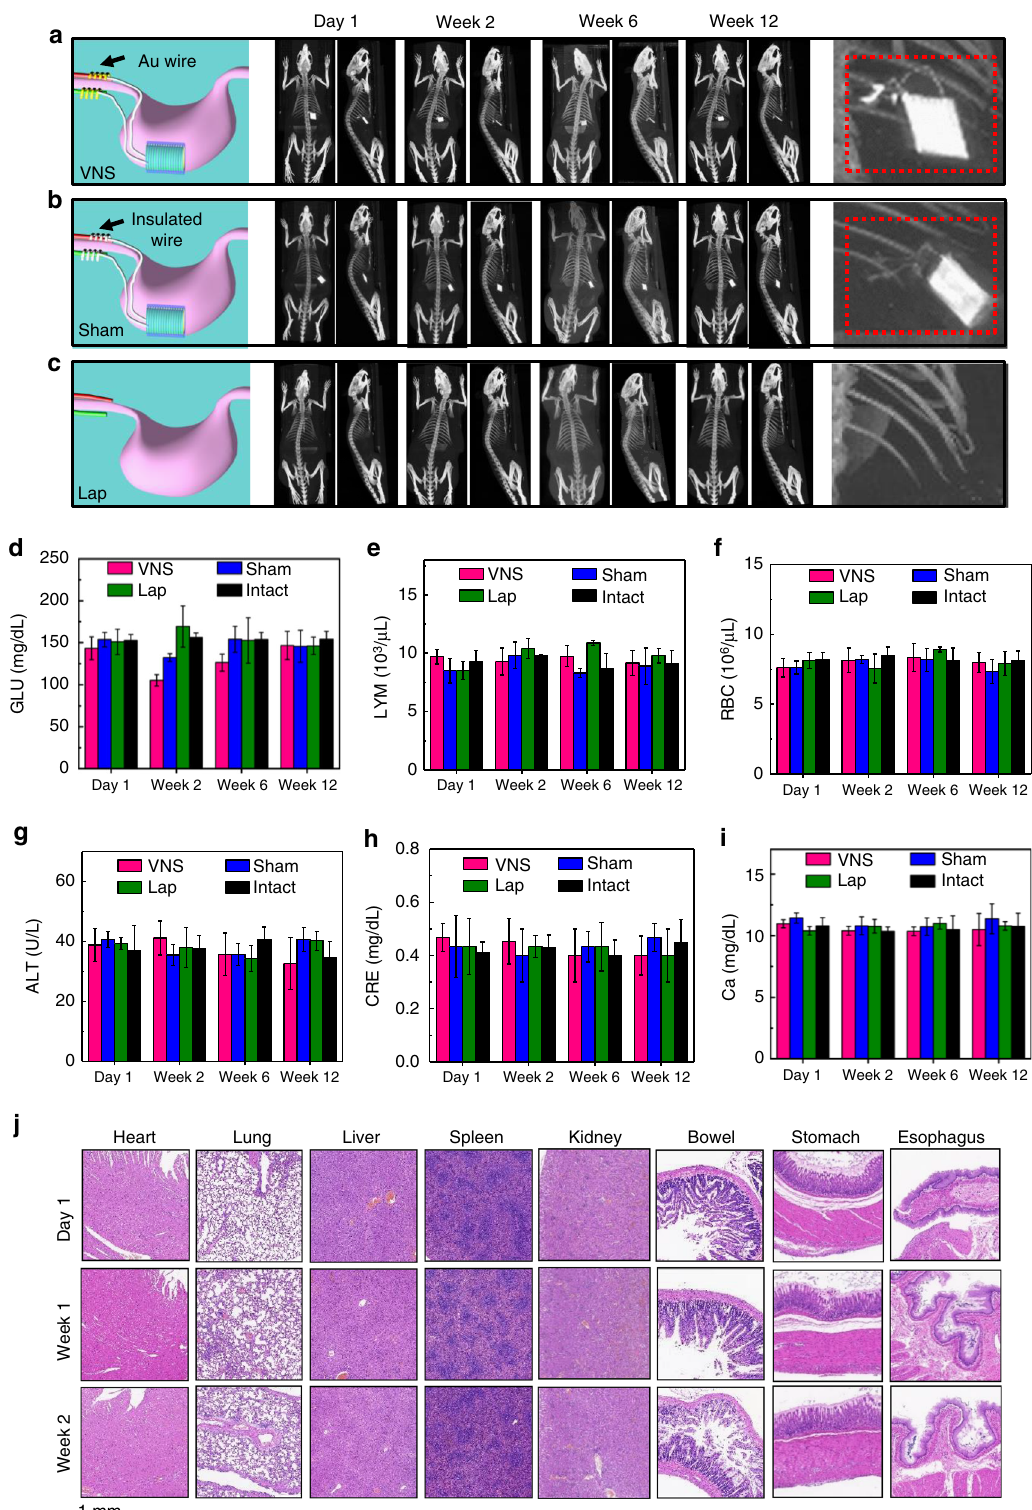
Fig. 3 Computed tomography (CT) 3D projection images and hematology data. a – c Serial CT images over time of the VNS group, Sham group, and Lap group, respectively. Schematics on the left show the setup of each group. A series of CT images (coronal and sagittal) show a representative rat for each group at different time points. The enlarged views of the implantation site are shown at the end. d – i Hematology results of all four groups over time ( n = 3 for each group). d Blood glucose (GLU) levels. e Infection-related lymphocytes (LYM) levels. f Hematopoietic function-related red blood cell (RBC) levels. g Hepatological function-related alanine aminotransferase (ALT) levels. h Renal function-related creatinine (CRE) levels. i Electrolyte metabolism-related calcium (Ca) levels. j H&E stains of vital organs (heart, lung, liver, spleen, kidney, bowel, stomach, and esophagus) at different time points (1 day, 7 days and 15 days) post implantation. All data in d – i are presented as mean ±